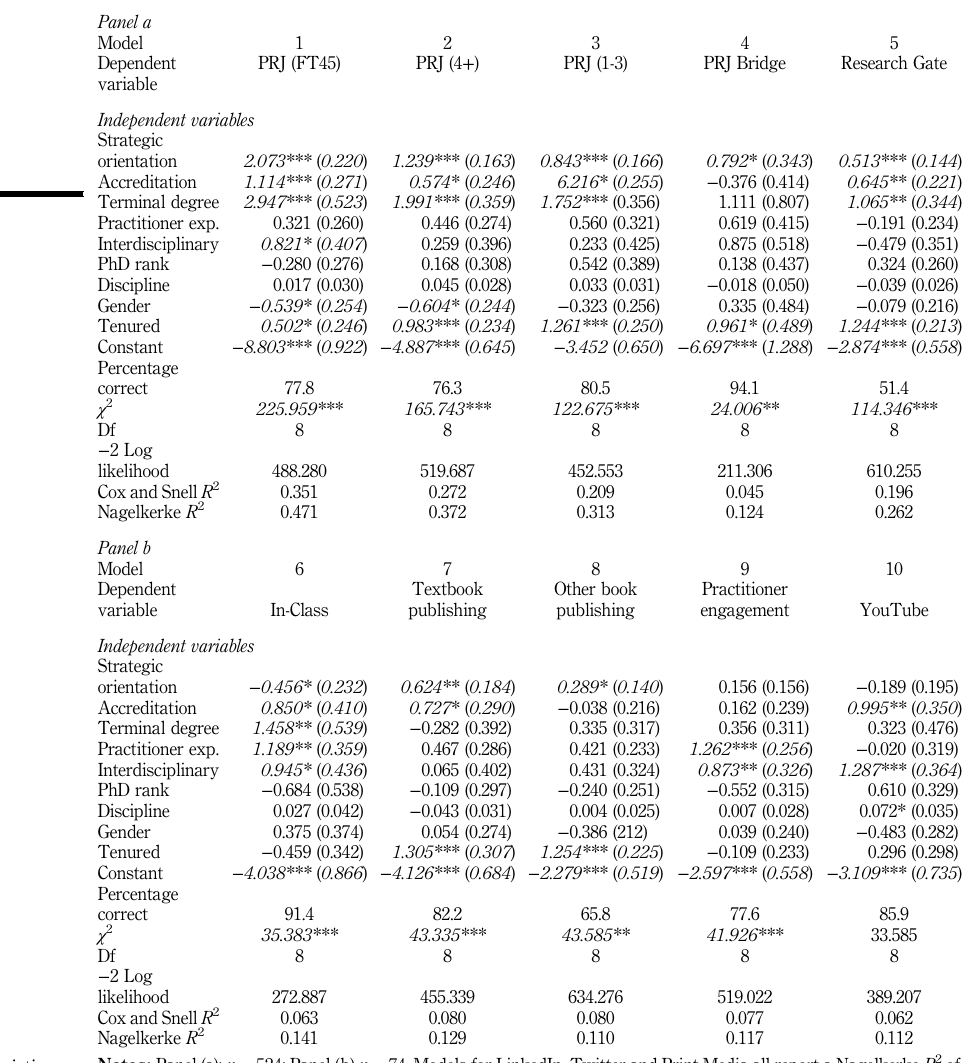
Table VI. Binominal logistic regressions predicting KD